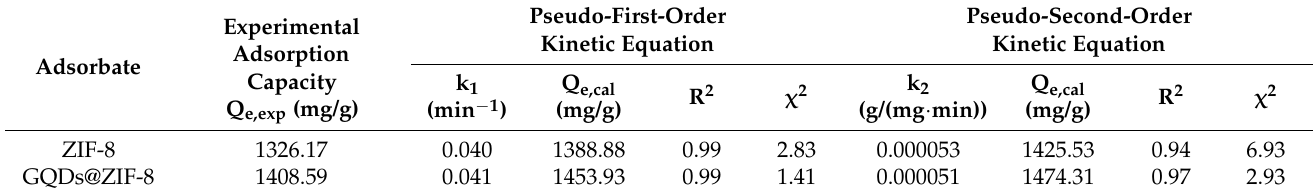
Table 3. Adsorption kinetic parameters of ZIF-8 and GQDs@ZIF-8 for ethyl acetate